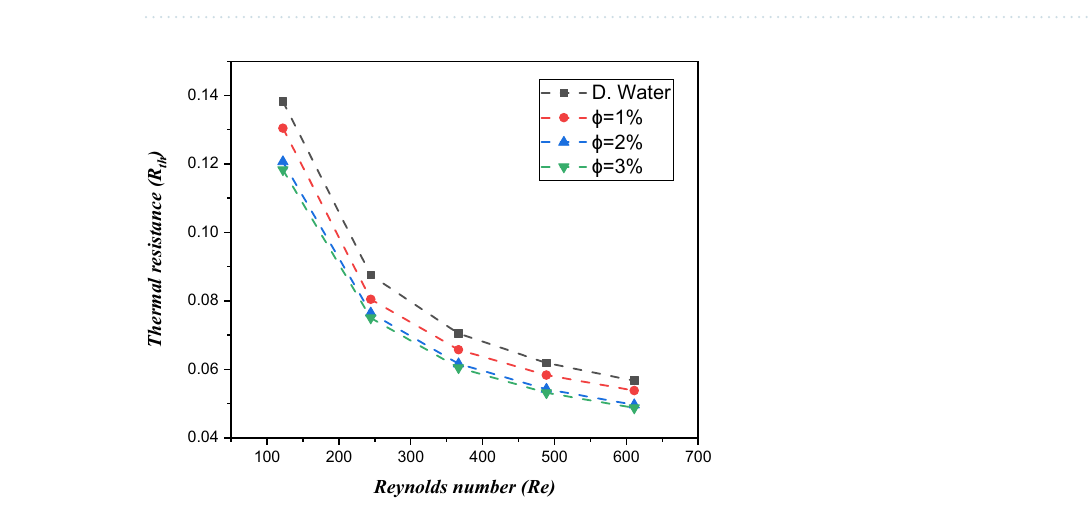
Figure 15. Heat transfer rate (Nusselt number) contour diagram influenced by volume friction and Reynolds number.